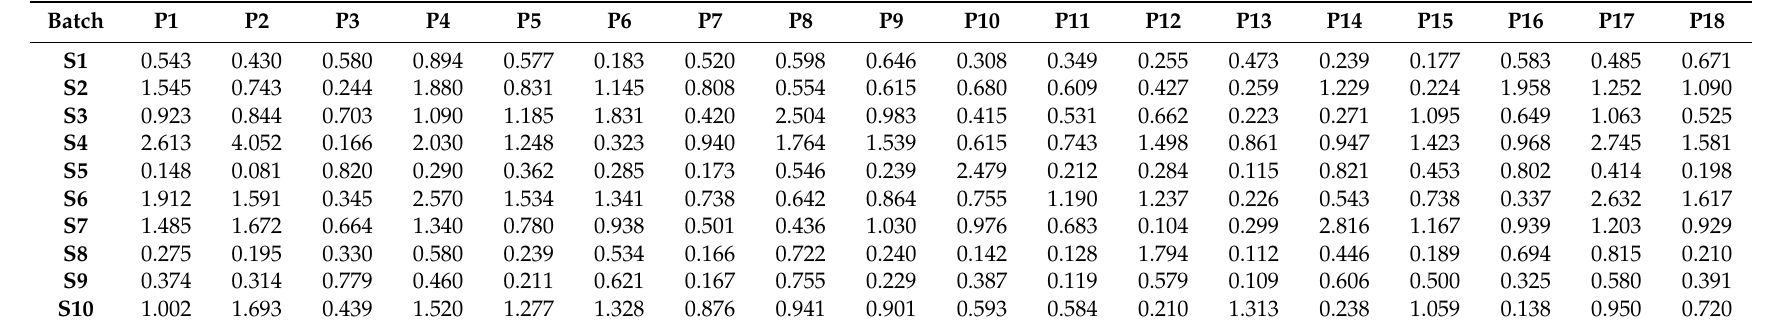
Table 4. Dimensionless data of peak areas of eighteen identified components (P1–P18) in ten different batches of panax ginseng saponins extracts from different origins (S1–S10) in example